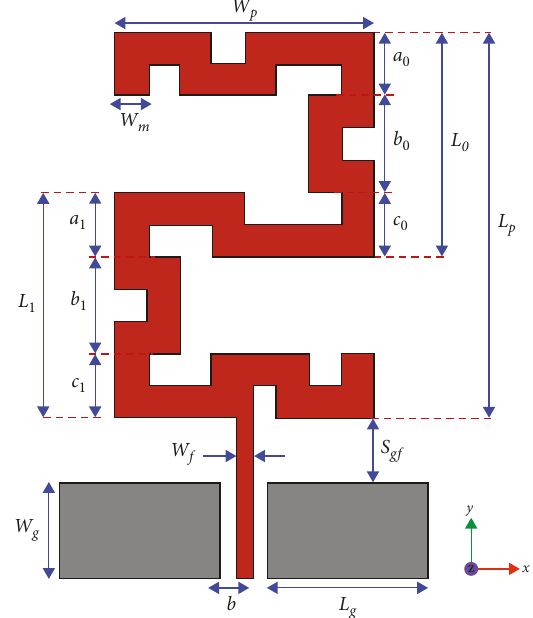
Figure 3: Configuration of the designed meander-line Z -shaped